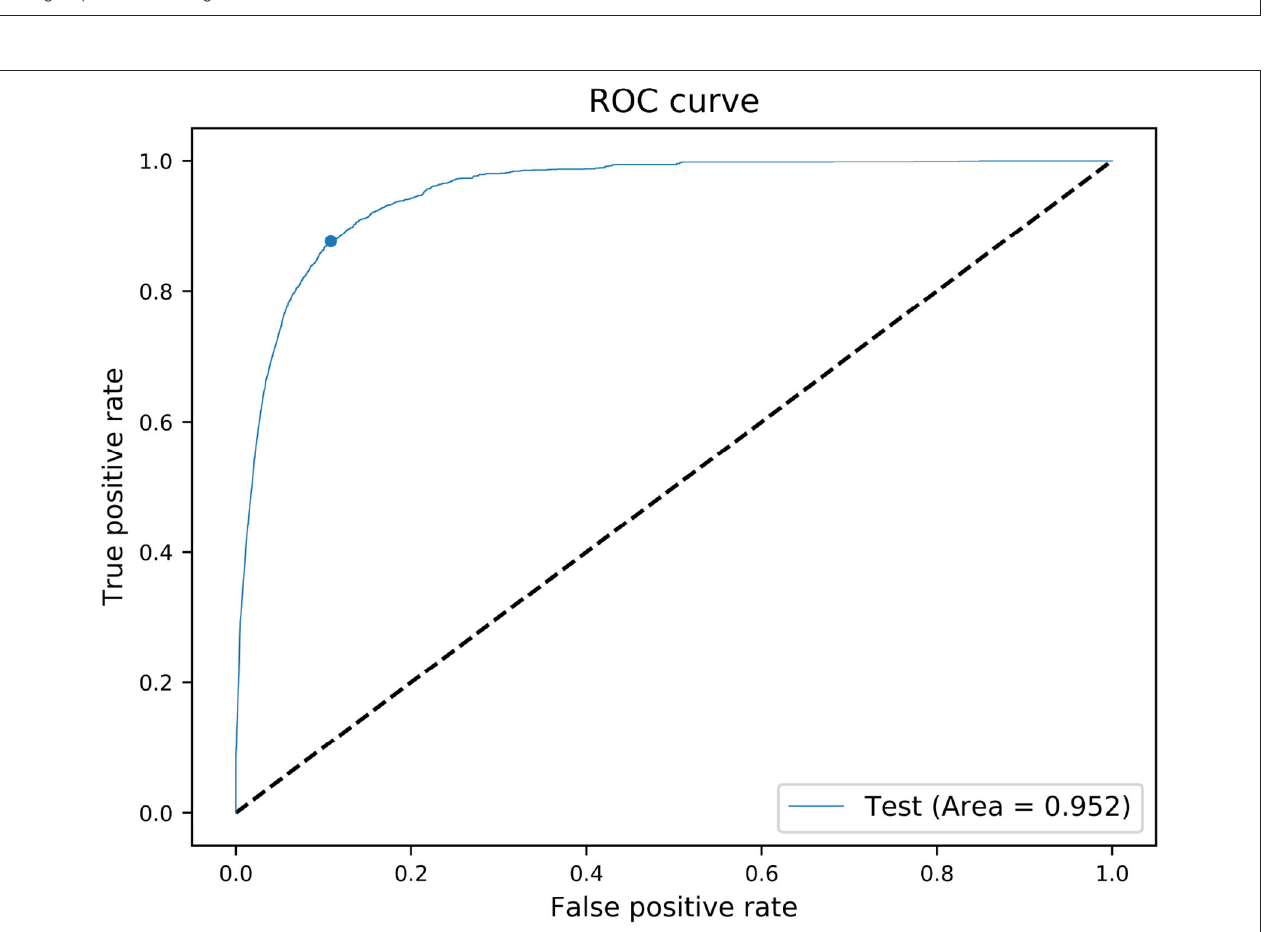
FIGURE 3 | ROC diagram used to tune the classification threshold for our imbalanced dataset. The TPR and FPR of the model have been evaluated for 6,000 classification thresholds from 0 to 1 and the model skill is represented by the blue curve. The blue dot is the optimal classification threshold, found by maximizing the TPR and minimizing the